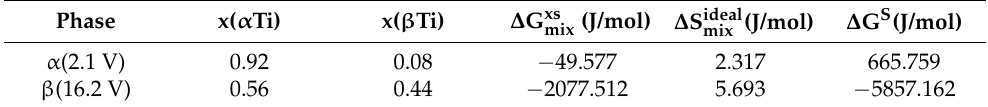
Table 2. Free energy of α (2.1 V) and β (16.2 V) at 810 ◦ C.